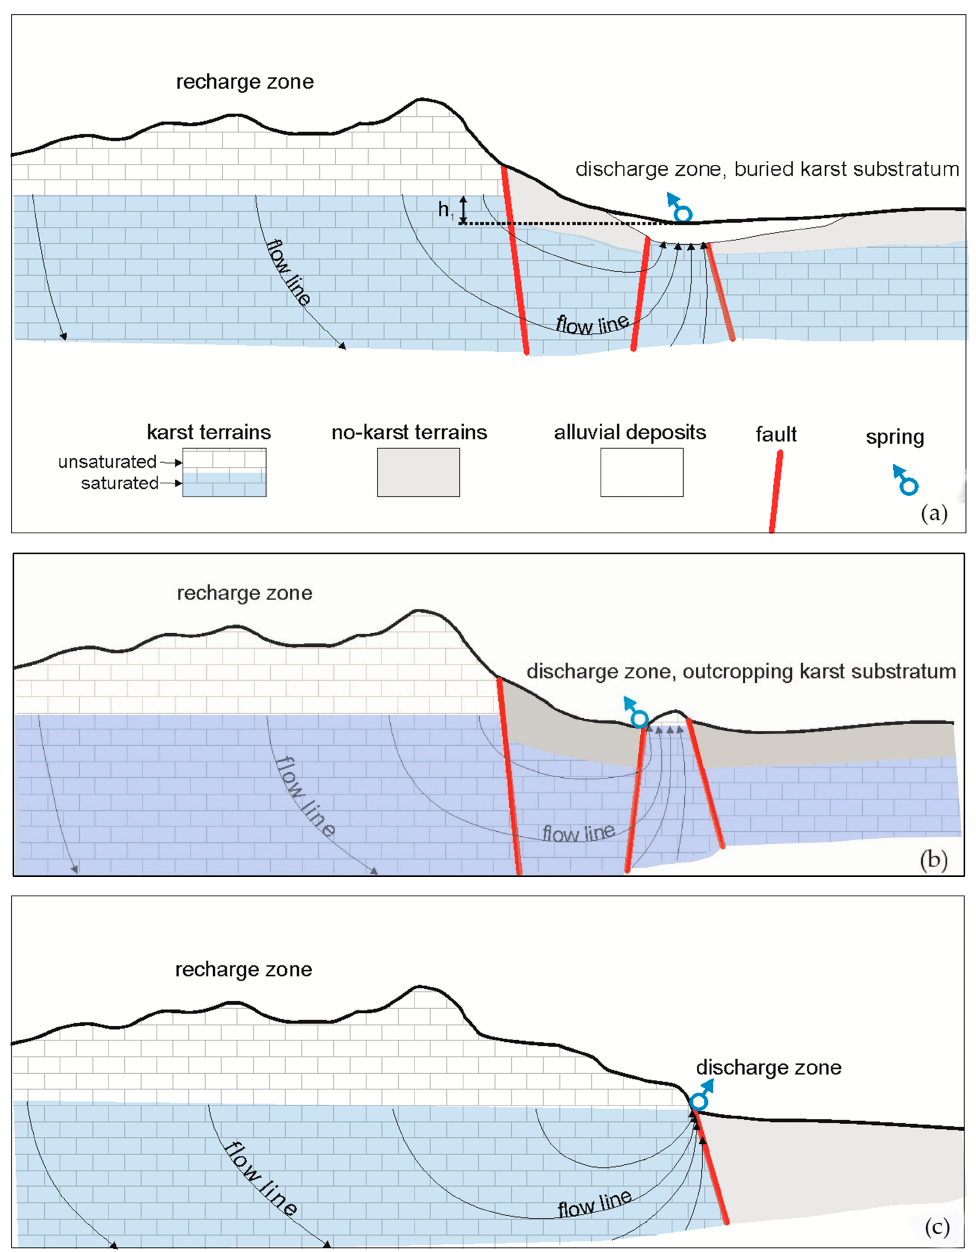
Figure 1 Figure 1. Ascendant flux connected to di ff erent hydrogeological settings of the discharge zone of